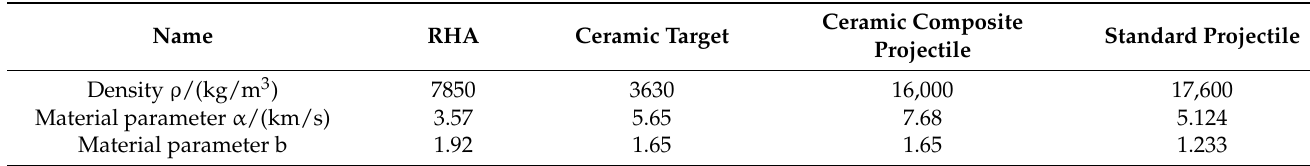
Table 5. Hugoniot Parameters of